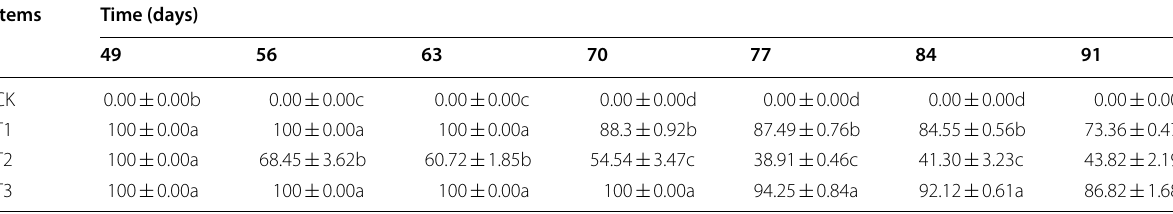
Different small letters in the same column meant significant difference among the treatments at P < 0.05 according to Duncan’s Multiple Range test after the particulate days of transplantation. Protective value extended from a subset of Fig.